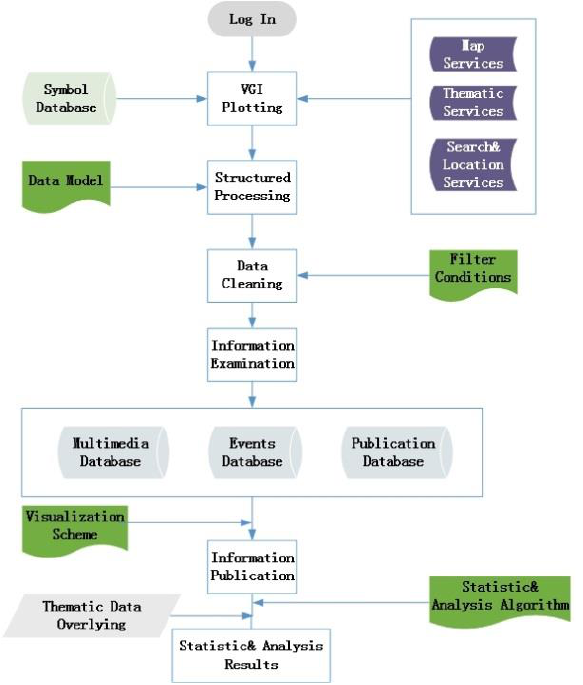
Figure 2. Crowdsourcing information utilization process on the